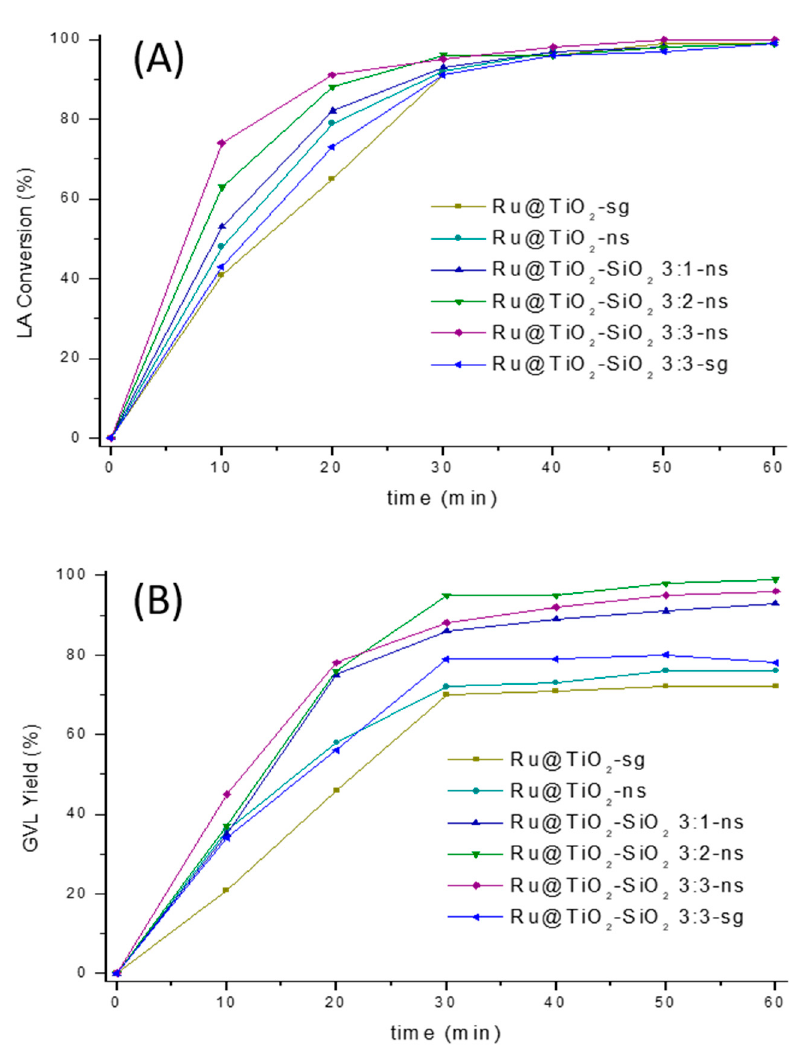
Figure 8. The influence of reaction time on the LA conversion ( A ) and the GVL yield ( B ) by various catalysts. Reaction conditions: 0.66 g LA (5.68 mmol), 77.6 mg supported catalyst (0.019 mmol Ru), 50 bar H 2 , 20 mL H 2 O, temperature 323 K, and reaction time 1 h.